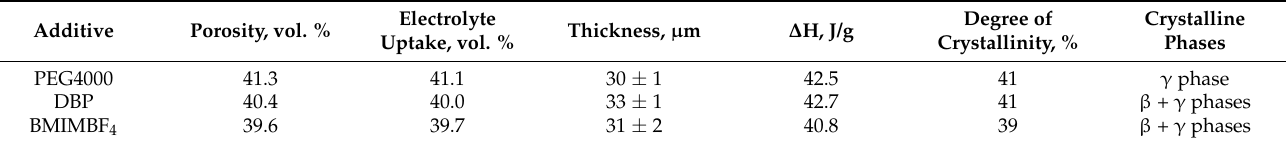
Table 4. Porosity, electrolyte uptake, thickness, DSC, and FT-IR data.